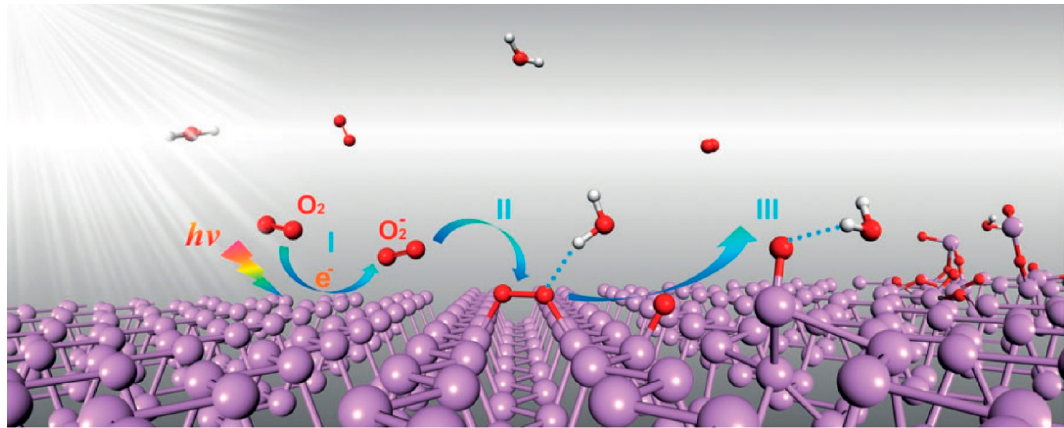
Figure 19. The light-induced ambient degradation process of phosphorene (Ph). Step 1: O 2 ‾ is generated through a charge transfer reaction under ambient light (O 2 + h ν → O 2 ‾ + h + ; where h + is a hole); step 2: O 2 ‾ dissociates at the surface and forms two P–O bonds with the phosphorene (O 2 ‾ + Ph + h + → P x O y ); step 3: through the hydrogen-bond interaction, water molecules draw the bonded O and remove P from the surface and break the top layer of phosphorene. Reproduced with permission from Ref. [131]. Copyright Wiley-VCH Verlag, 2016.